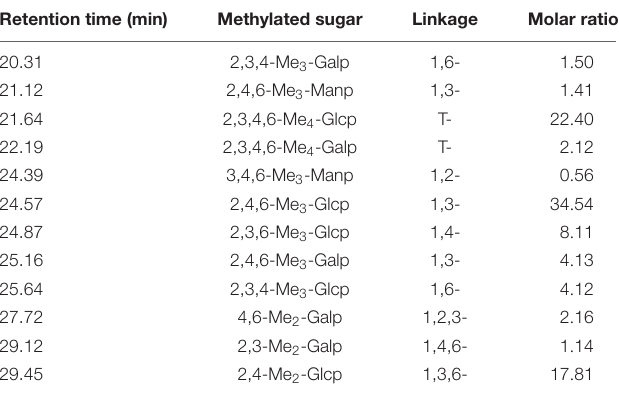
TABLE 1 | GC–MS analysis of the methylated products of RGLP-1.